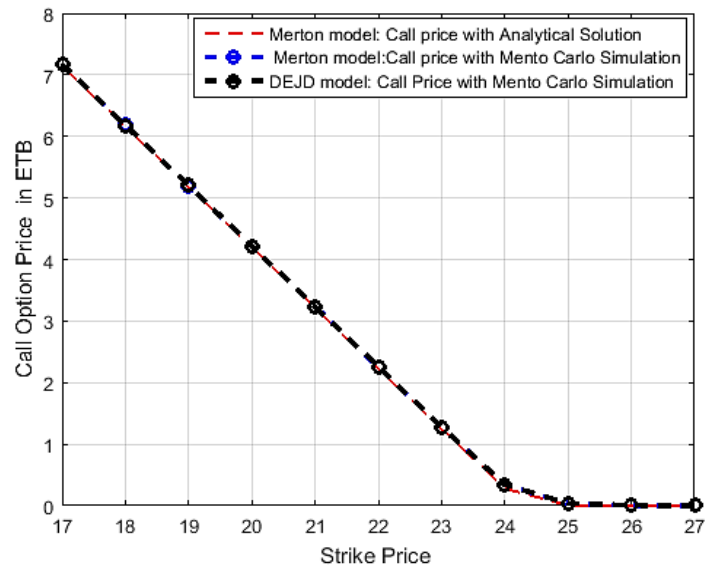
Figure 12. Call option WHGS3 price under DEJD and Merton’s models.